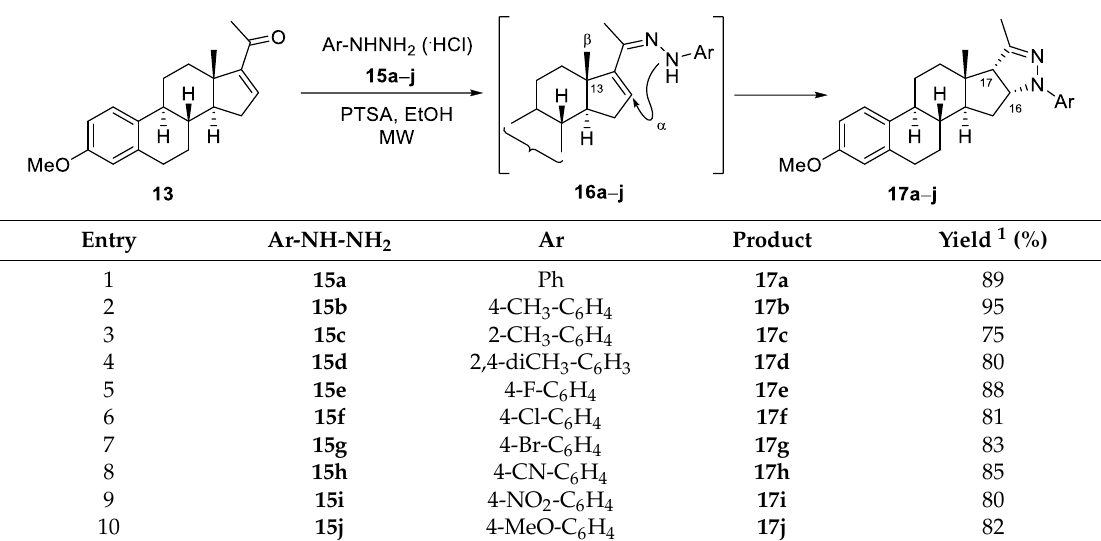
Molecules 2019 , 24 , x FOR PEER REVIEW 6 of Table 1. Stereoselective syntheses of ring D -fused 1 (cid:48) -aryl-2 (cid:48) -pyrazolines in the estrone series.